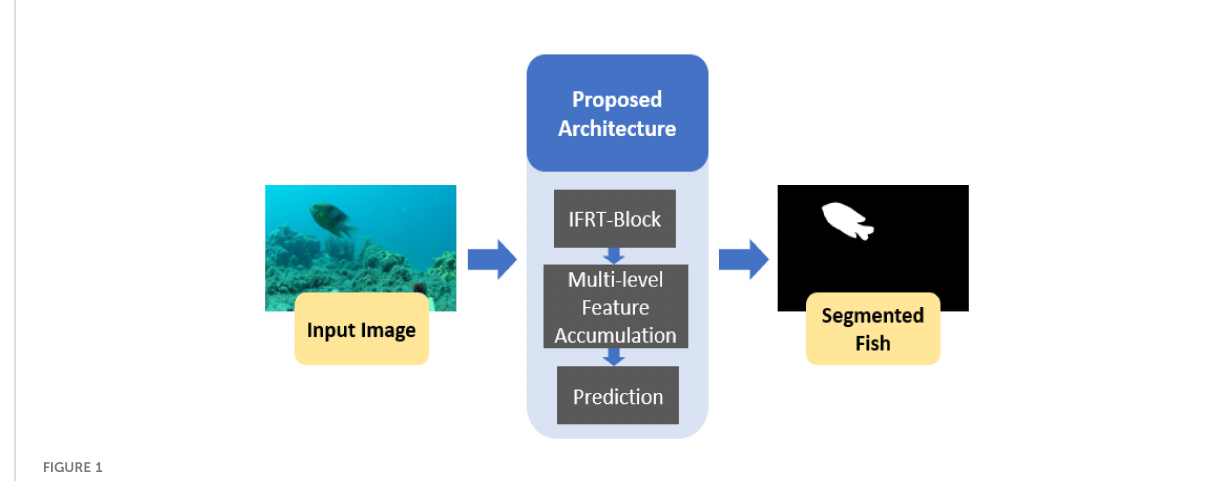
FIGURE 1 Overview of the proposed